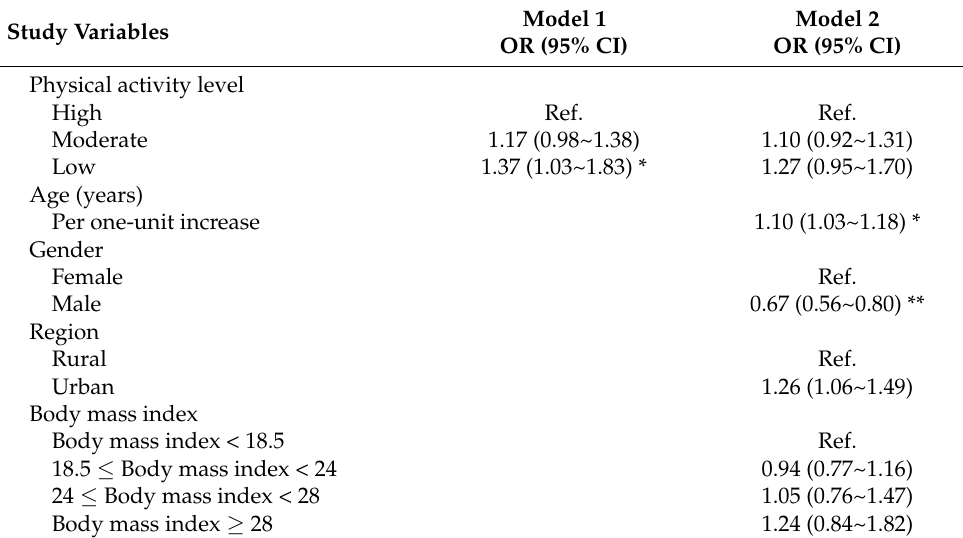
Associations between physical activity and poor sleep quality among Chinese college